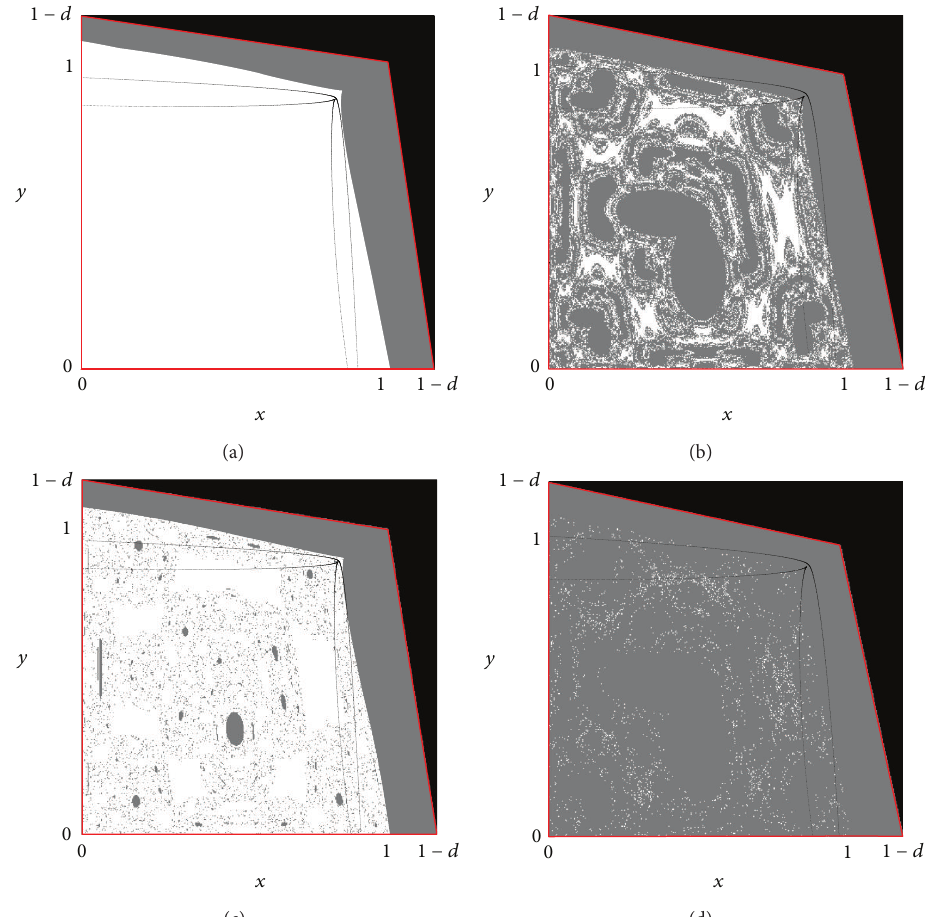
Figure 2: Parameter values: 𝛼 = 1.5 , 𝑤 = 0.5 , 𝑏 1 = 0.4 , and 𝑏 2 = 0.2 . (a) 𝐷 has a simple structure ( 𝑑 = −0.15 ). (b) 𝐷 has a complex structure ( 𝑑 = −0.2 ). (c) Set 𝐷 after the contact bifurcation ( 𝑑 = −0.16 ): gray holes are depicted. (d) Immediately before the final bifurcation ( 𝑑 = −0.216 ) almost all trajectories are